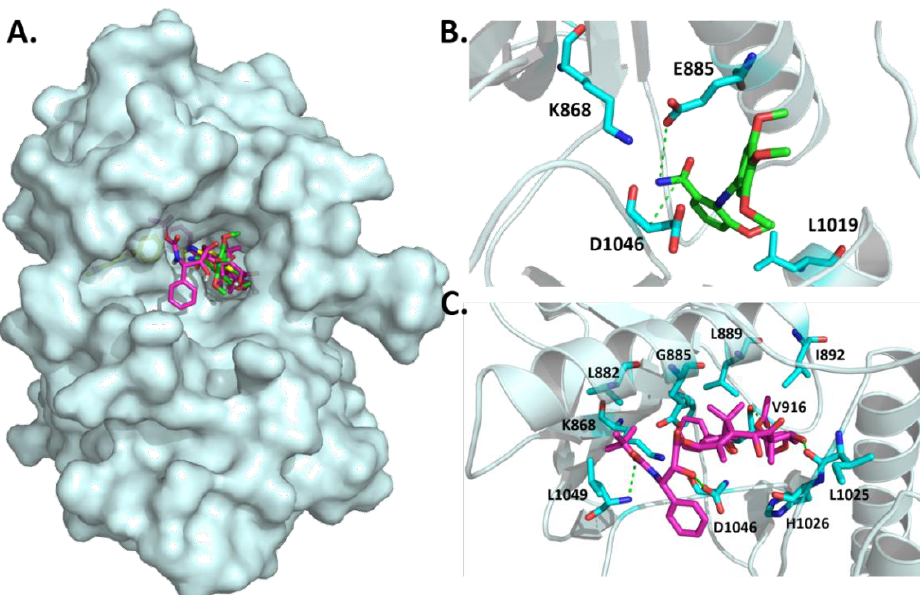
Figure 6 . The binding of M6 to VEGFR2 tyrosine kinase (PDB ID: 4ASD). ( A ) Surface representation for the binding mode of M6 (green), docetaxel (pink), and co-crystallized sorafenib (yellow) to VEGFR2 tyrosine kinase. Ribbon representation for the binding interaction of ( B ) M6 (green) and ( C ) docetaxel (pink) with VEGFR2 tyrosine kinase. Hydrogen bonds are shown in green dashed lines.